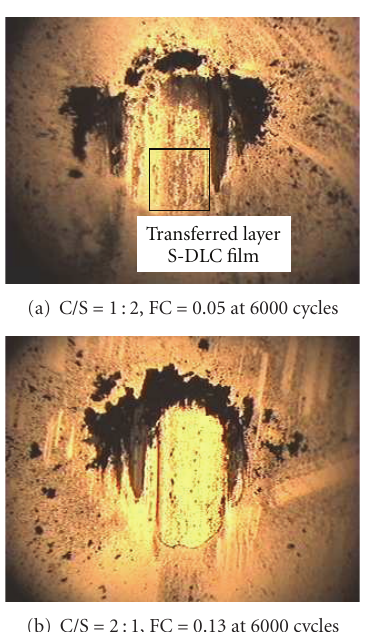
Figure 5: Wear scar micrographs on SUS440C balls with C/S flow- rate ratio of (a) 1 :2 and (b) 2 :1 at bias voltage of − 5kV under ambient air.